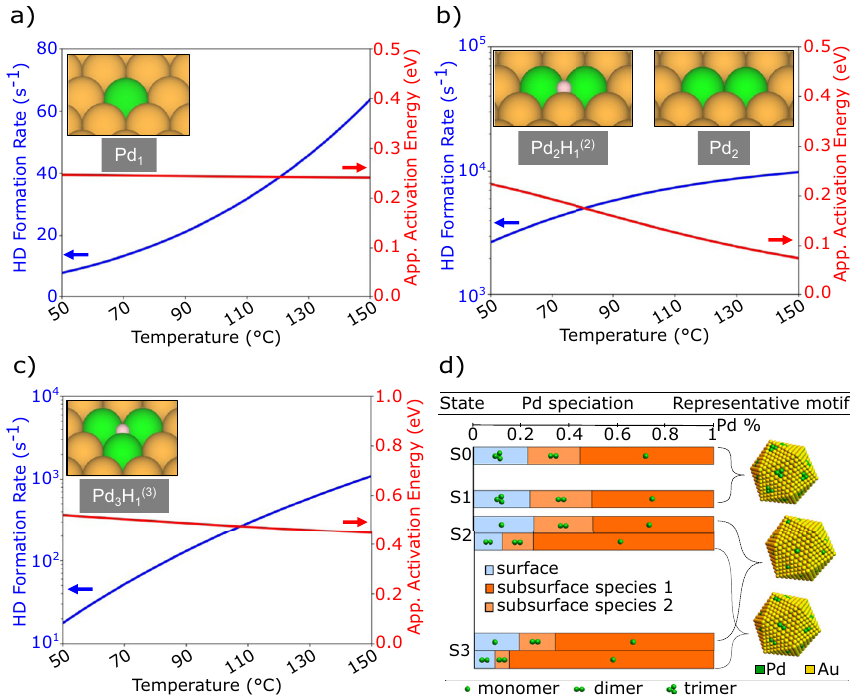
Fig. 4 First-principles-based microkinetic modeling bridges theory and experiment. a – c Computed activity, the apparent activation energy ( E a ), and most abundant intermediates (insets; superscript = H-Pd coordination number) of HD exchange reaction on dilute Pd ensembles. The activity increases in the order of Pd monomers, trimers, and dimers. At 50 °C, trimers have a higher E a (0.52 eV) compared to monomers and dimers (0.20 – 0.25 eV). d Pd speciation (at.%) within the surface (blue) and subsurface/bulk (light and dark orange) responsible for the observed coordination numbers in the initial state (S0), and after pretreatments A (S1), B (S2), and C (S3). On the basis of theoretical modeling, surfaces of S0/S1 are constrained to trimers, and either monomers or dimers for S2 and S3 each. a – d Pd atoms are green and Au atoms are yellow.